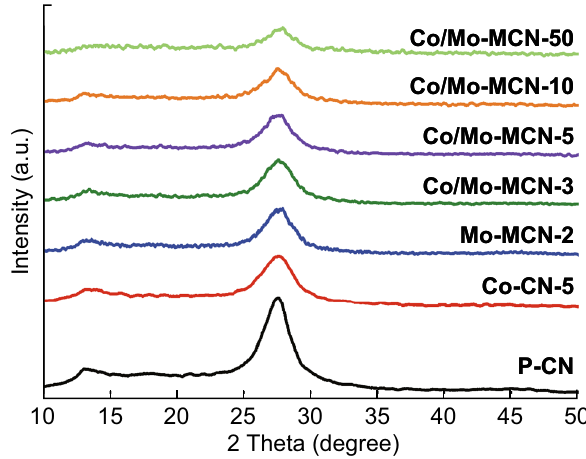
Fig. 1 XRD patterns of P-CN, Co-CN-5, Mo-MCN-2, and Co/Mo- MCN composites